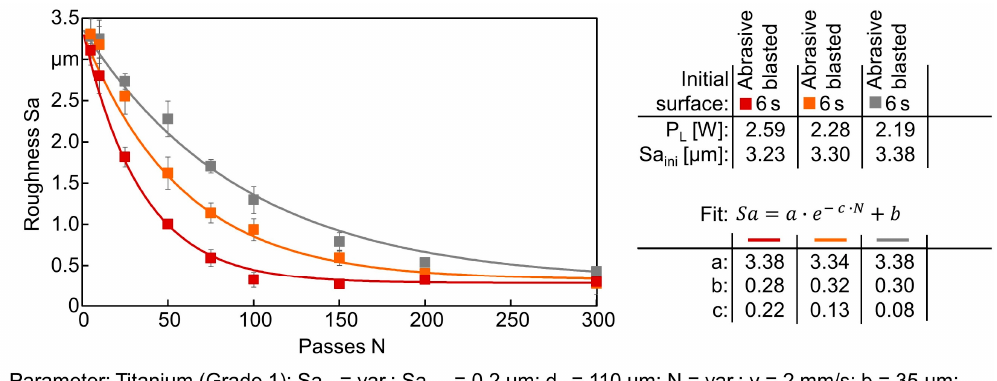
Figure 7. Roughness over number of passes for different laser powers and the corresponding Figure7. Roughnessovernumberofpassesfordi ff erentlaserpowersandthecorrespondingexponential exponential fit parameter. fit parameter.